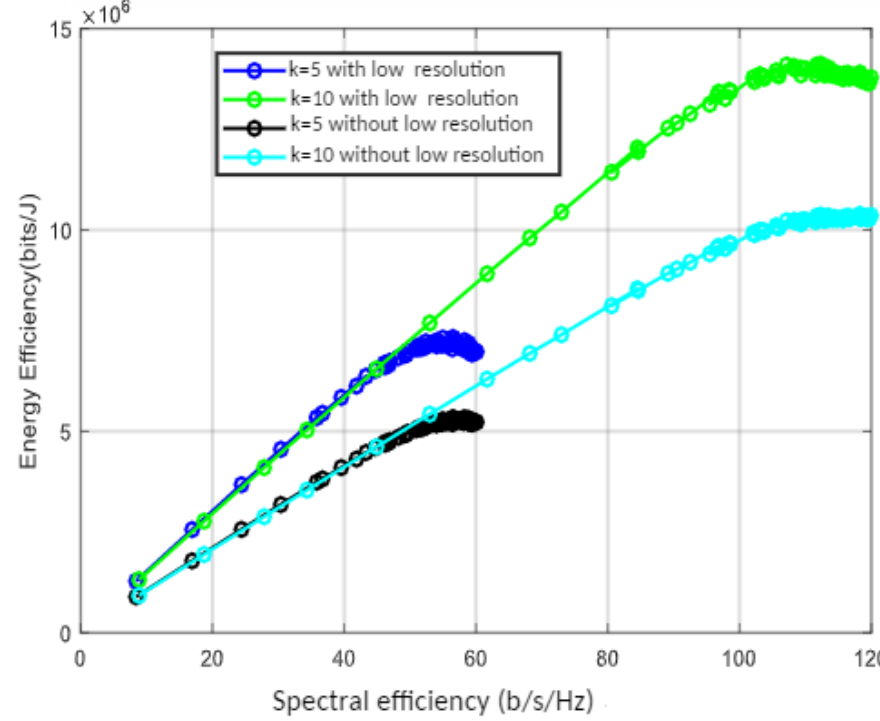
Figure 6. Energy efficiency versus spectral efficiency with without low resolution